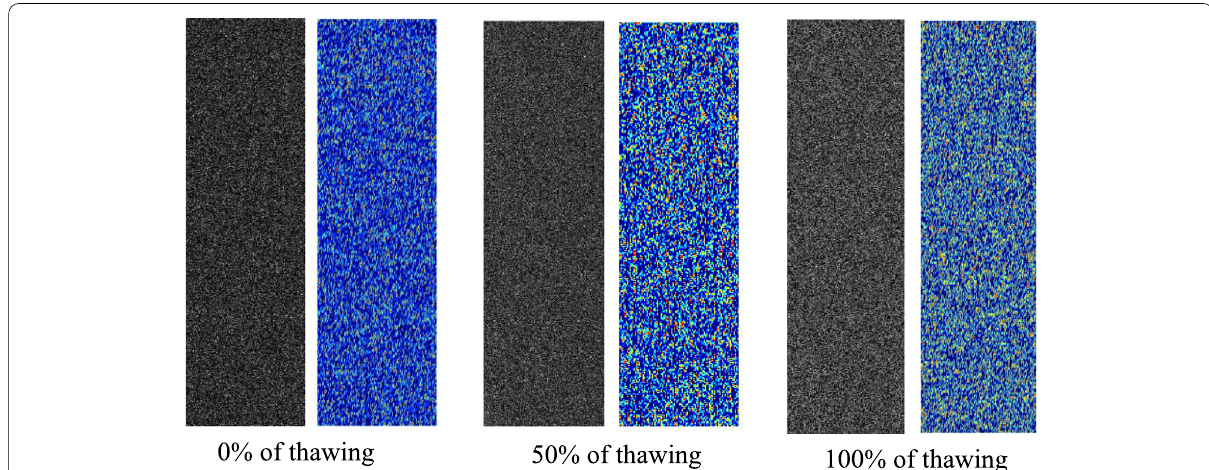
Fig. 4 Phase coded microstructure-based image for silt sample with different degrees of thawing (the gray-scale image is phase coded in Matlab, the color image is phase coded after conversion into